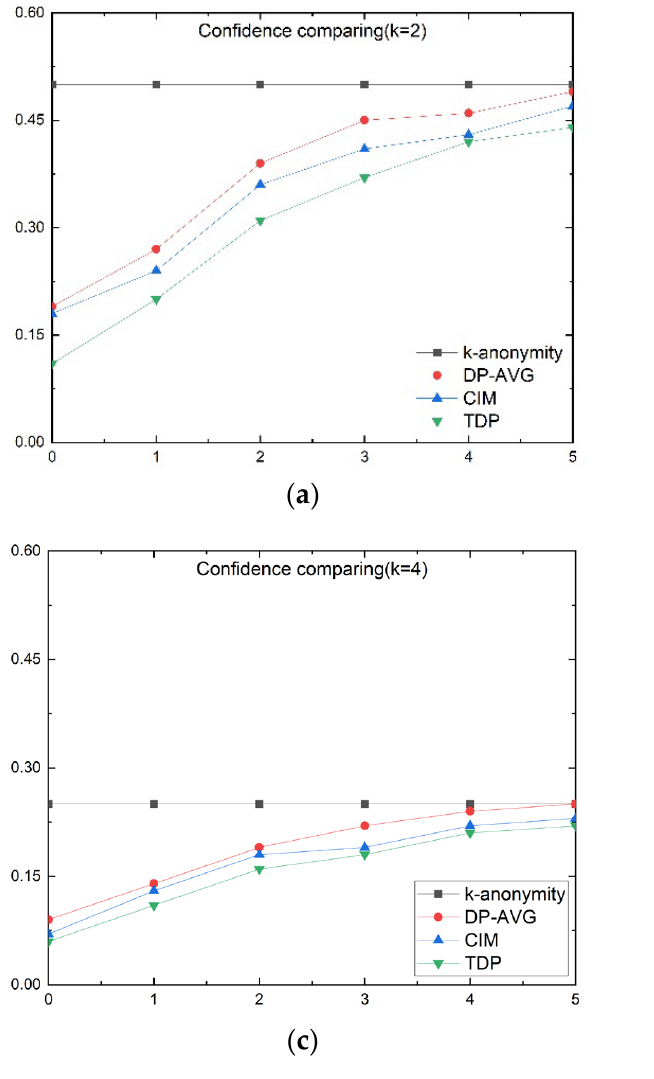
Figure 5. Confidence comparison diagram. ( a ) k = 2. ( b ) k = 3. ( c ) k = 4. ( d ) k = 5.